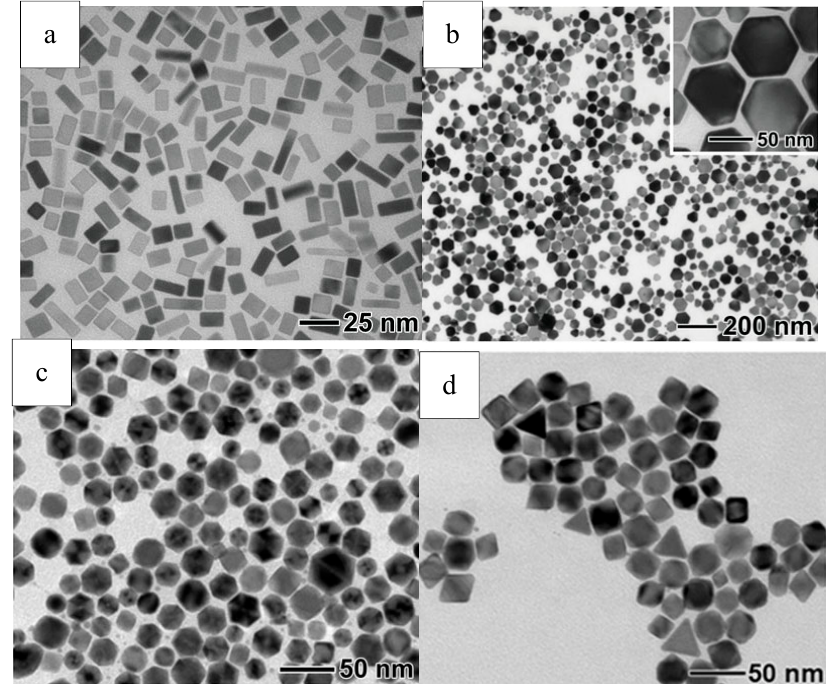
Figure 7. Typical Pd nanocrystals of different morphology ( a ). nanobars; ( b ). hexagonal and triangular Pd nanoplates; ( c ). icosahedrons; ( d ). octahedrons). Reproduced with permission [47]. Copyright 2009,